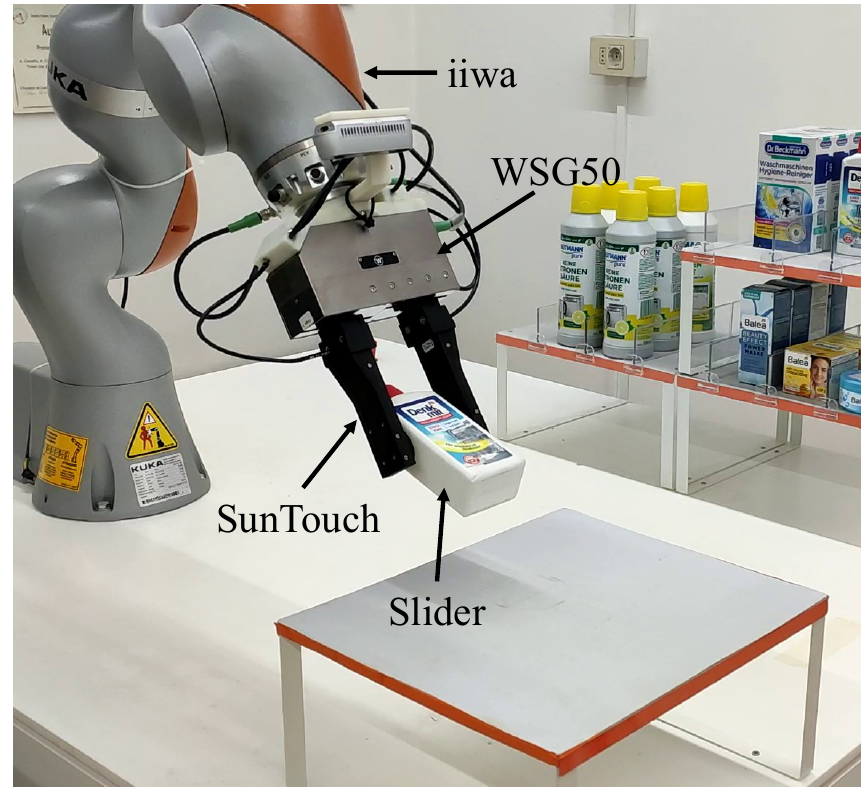
Figure 8. Manipulated objects. From left to right: big resin block, small resin block, plastic bottle, aluminum can.